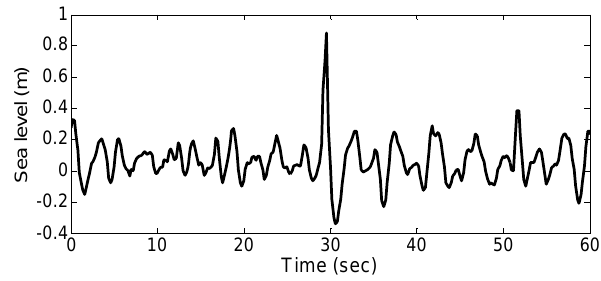
Figure 2. The freak wave record on 9 July 2008. Fig. 2. The freak wave record on 9 July